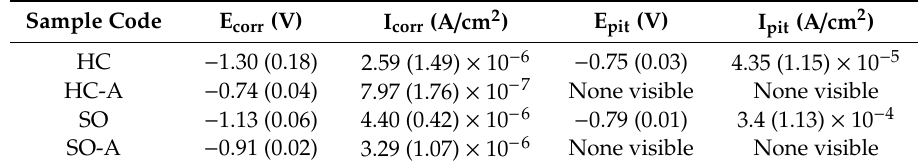
Figure 7. TEM photographs and diffraction patterns of Al 2 CuMg precipitates in ( a ) and ( b ) the SO sample; ( c ) and ( d ) the HC sample. Table 4. Potentiodynamic polarization measured for HC and SO samples (HC-A and SO-A: anodized samples); standard deviations are included in the